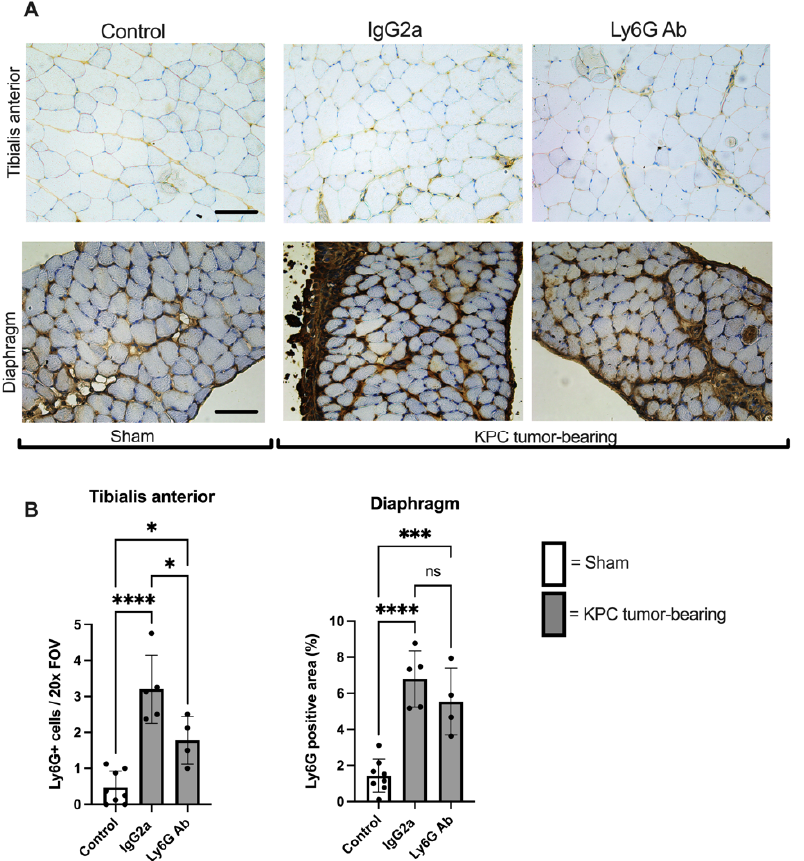
Figure 4. Increased presence of Ly6G+ cells in limb muscles of KPC mice is blunted with anti-Ly6G Ab treatment. ( A ) Representative cross-sectional images of tibialis anterior and diaphragm muscles from Sham (Control; n = 8) and KPC mice treated with either isotype control antibody ( n = 5) or anti-Ly6G antibody ( n = 4) were stained for the Ly6G antigen. Images were analyzed and are quantified in panel ( B ). Four randomly selected 20× images were analyzed for each mouse of each group. Open bars = Sham (Control). Grey bars = KPC. * p < 0.05, *** p < 0.001, **** p < 0.001, ns = not significant. Scale bars = 100 μ m.